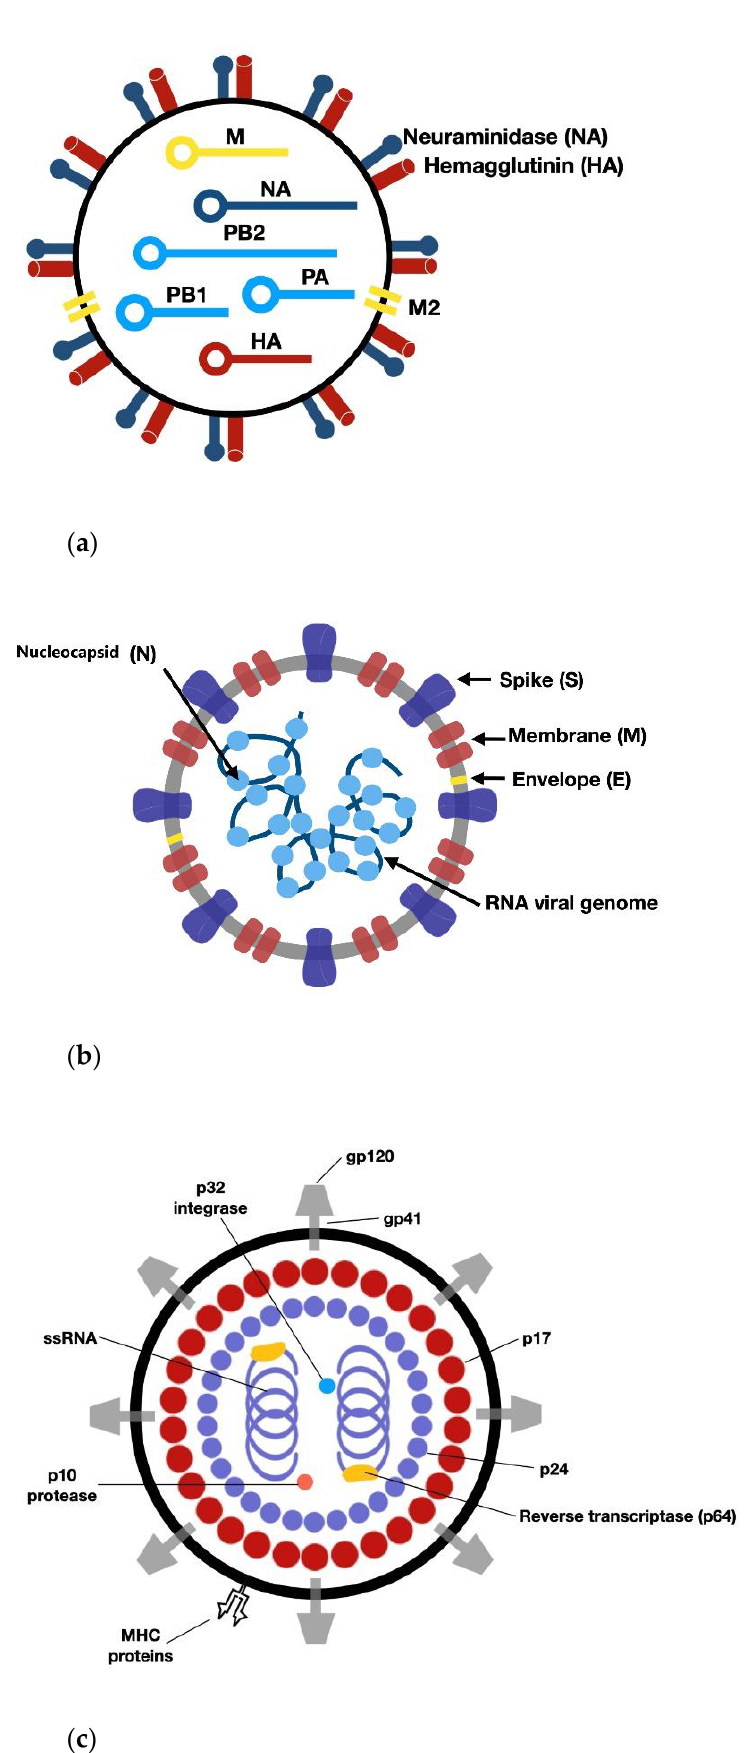
Figure 1. Structure of the three RNA viruses. ( a ) IV is an RNA virus 90–100 nm in diameter. The virions are covered with a double-layered lipid membrane derived from the host cell taken up when the virus left the cell. This envelope contains two glycoproteins: hemagglutinin and neuraminidase. The influenza virus has 3 subtypes: A, B, and C variants. The A variant can be further classified